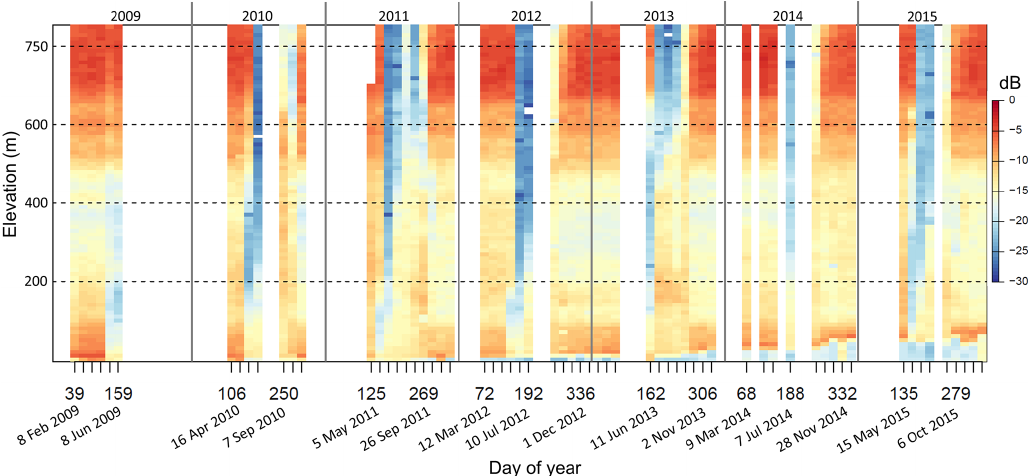
Figure 5. RADARSAT-2 time series of SAR backscatter values (dB) along a centerline profile on Kongsvegen from 2009 to 2015. An abrupt change in the start and end of melting season (e.g., in year 2012 and 2013) was observed. The backscattering values are in decibel